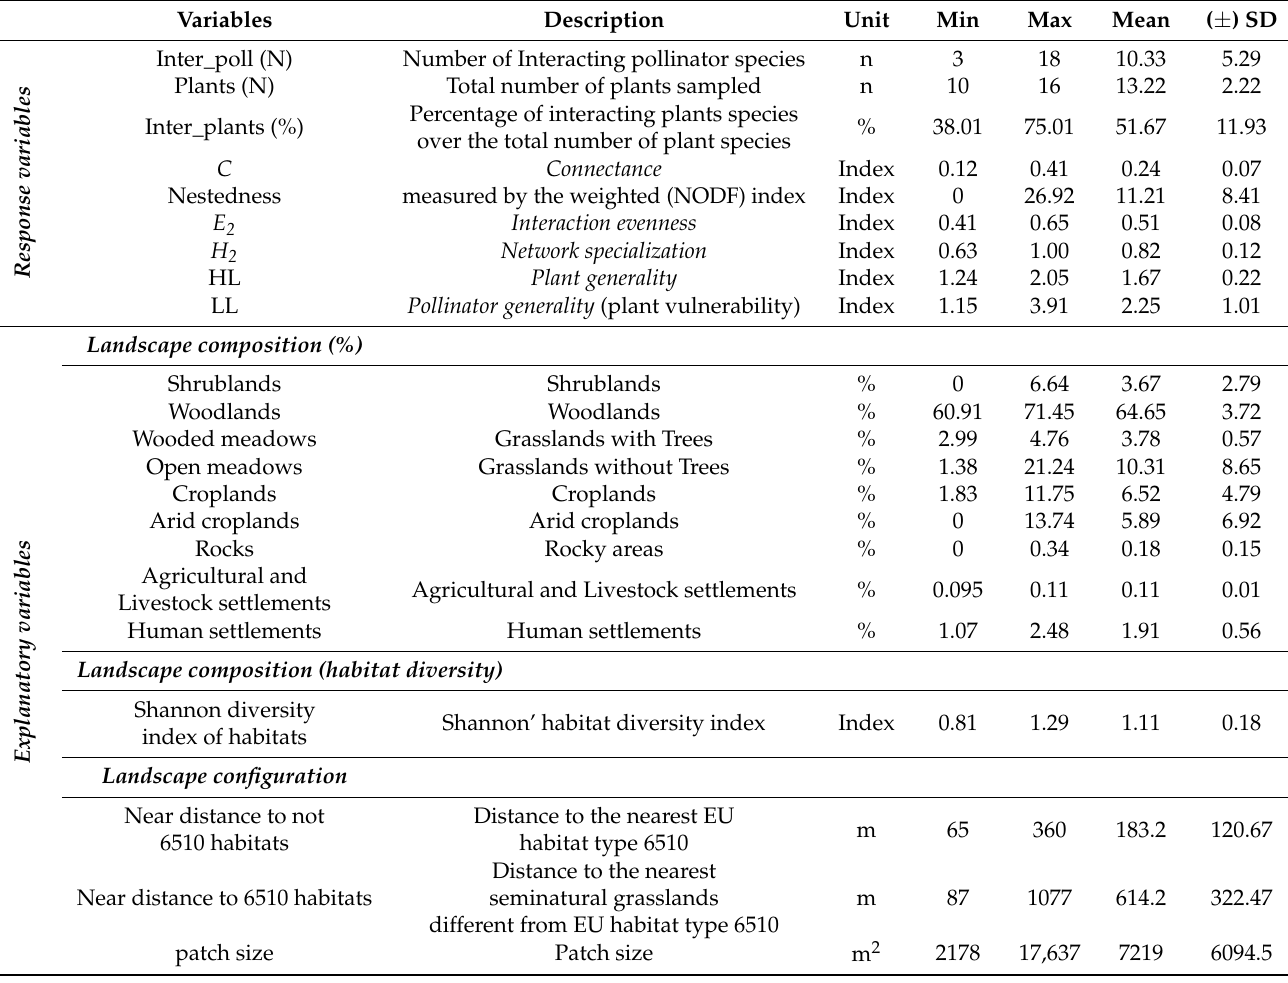
Table 1. Variables considered in the development of generalized linear models to estimate the effects of landscape composition and configuration on plant and pollinator richness and on seven network descriptors. Minimum; maximum; mean ± standard deviation (SD) values are